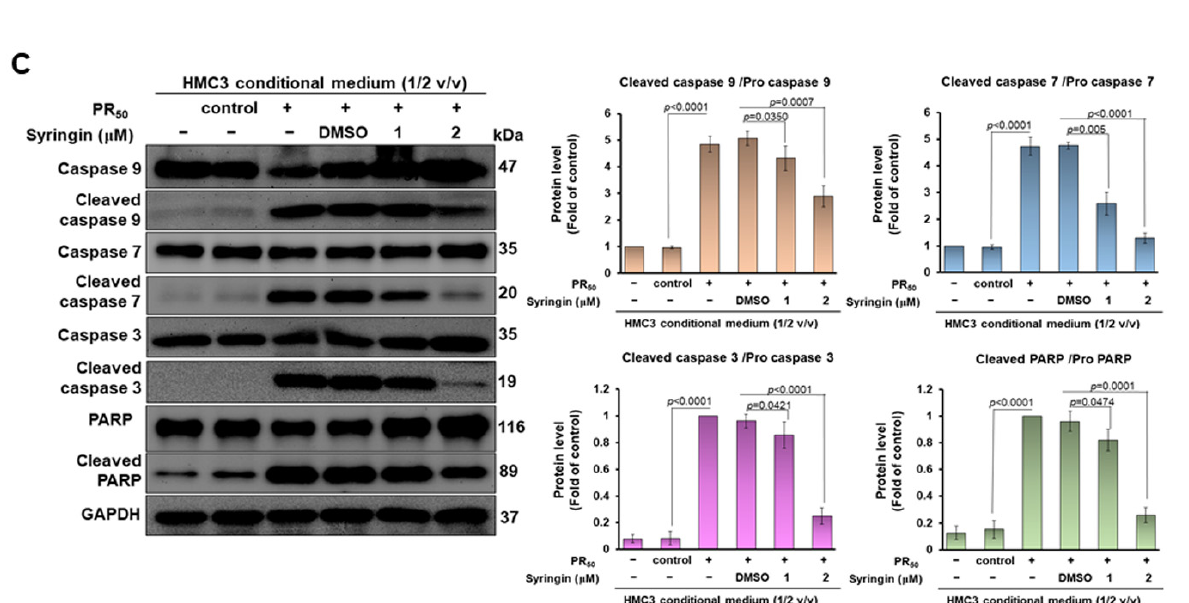
Figure 10. Treatment with syringin (SRG) abolished the ability that PR-CM caused apoptosis in mouse NSC-34 motor neuron cells. ( A ) NSC 34 cells were treated with 0.25, 0.5, 1, 2, 4, or 8 μ M SRG for 24 h. Finally, the cell survival rate was determined by MTT assay. ( B ) NSC-34 cells were treated with SRG-treated or untreated PR-CM at 1/2 ( v / v ) ratios for 24 h. Cell death and apoptosis were measured by lactate dehydrogenase (LDH) release via ELISA and apoptotic-cell numbers via TUNEL assay. ( C ) Western blotting was used to quantify the levels of apoptotic core proteins (leaf panel). ImageJ software was used to obtain the signal intensity of the image (right panel). The loaded internal control is GAPDH.